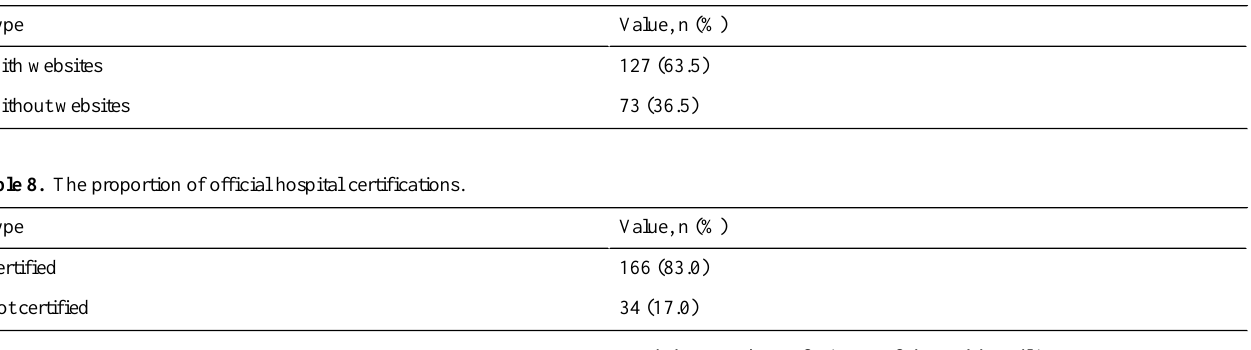
Table 7. The website proportion of WeChat official accounts.